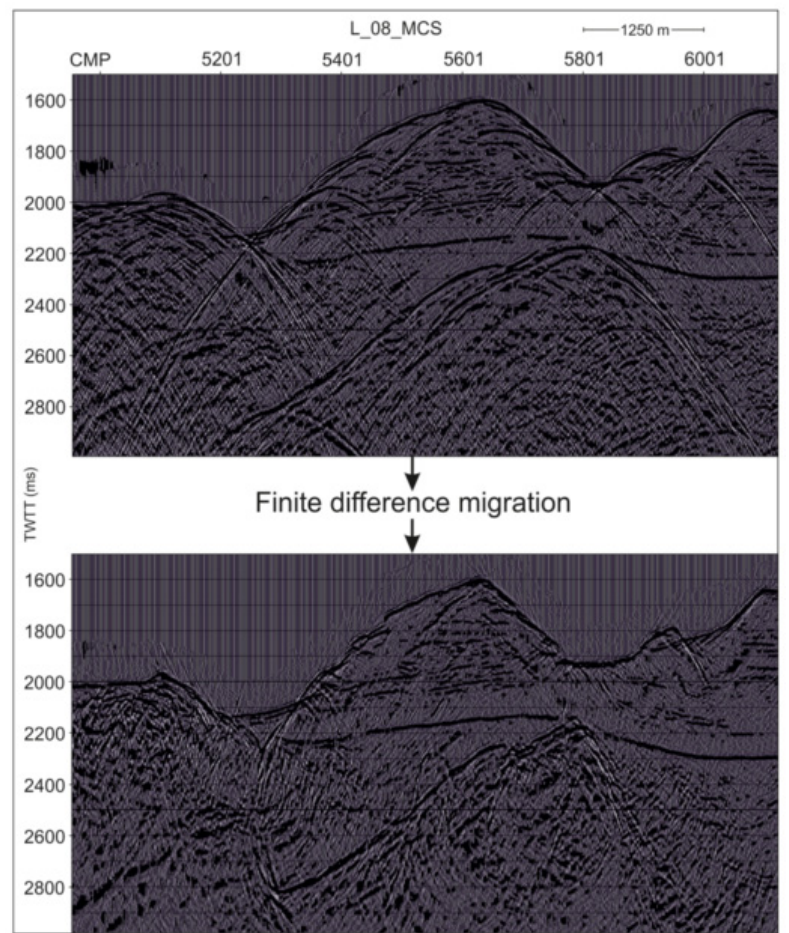
Figure 15. Unmigrated (top) and time-migrated (bottom) stacks of a portion of the L_08_MCS line (Ionian Sea, see Figure 2 for line